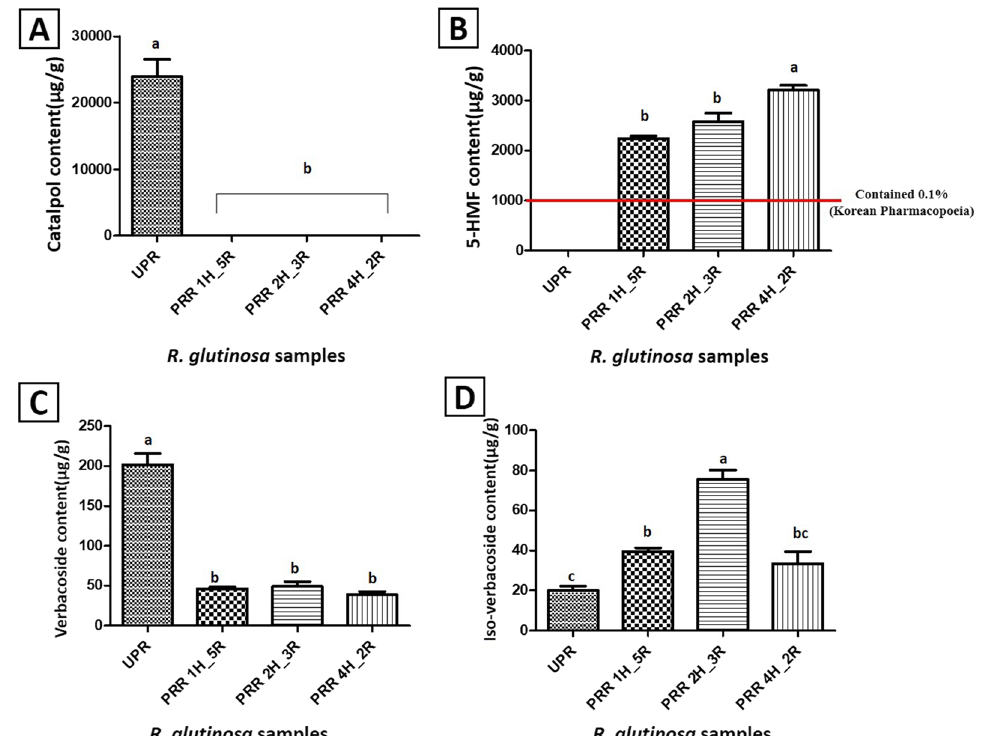
Fig. 4 Effect of different steaming times (five times) and steaming duration (1 h, 2 h, and 4 h) on marker compounds content of R. glutinosa samples. a Catalpol content of R. glutinosa samples. b 5-HMF content of R. glutinosa samples. c Verbacoside content of R. glutinosa samples. d Iso-verbacoside content of R. glutinosa samples. * UPR Unprocessed R. glutinosa , PRR Processed R. glutinosa . Values are presented as means standard deviation. Same letters are not significantly different by Tukey’s test and p ±